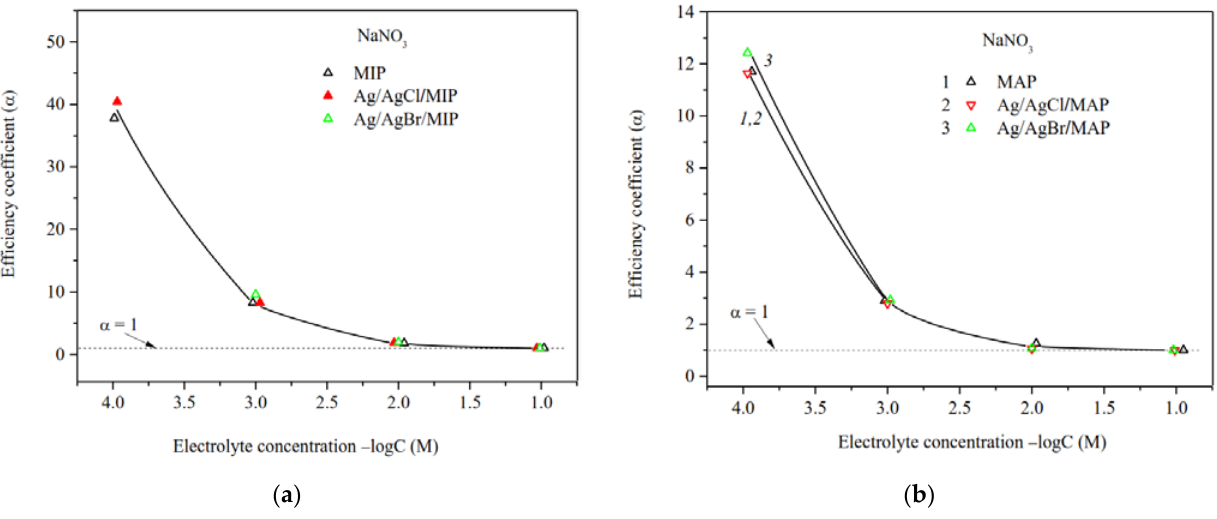
Figure 7. Efficiency coefficients of the base (Ermakova, 2022. Ref. {34]) and Ag/AgHal-modified MIP ( a ) and MAP ( b ) membranes vs. NaNO 3 solution concentration. ( a ) and MAP ( b ) membranes vs. NaNO 3 solution